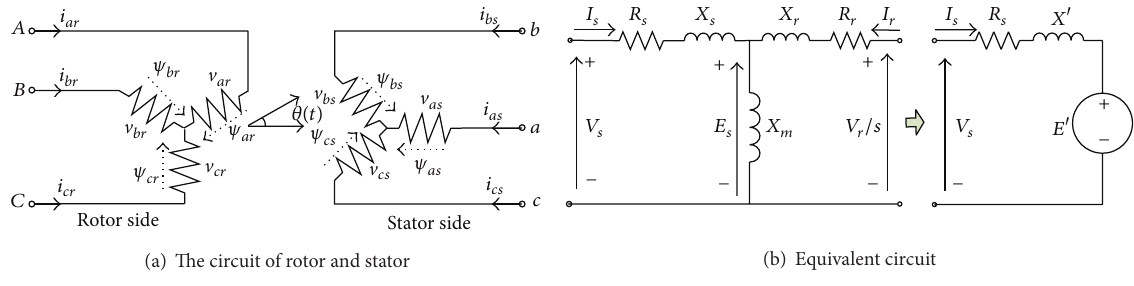
Figure 2: The equivalent electric circuit of the DFIG.